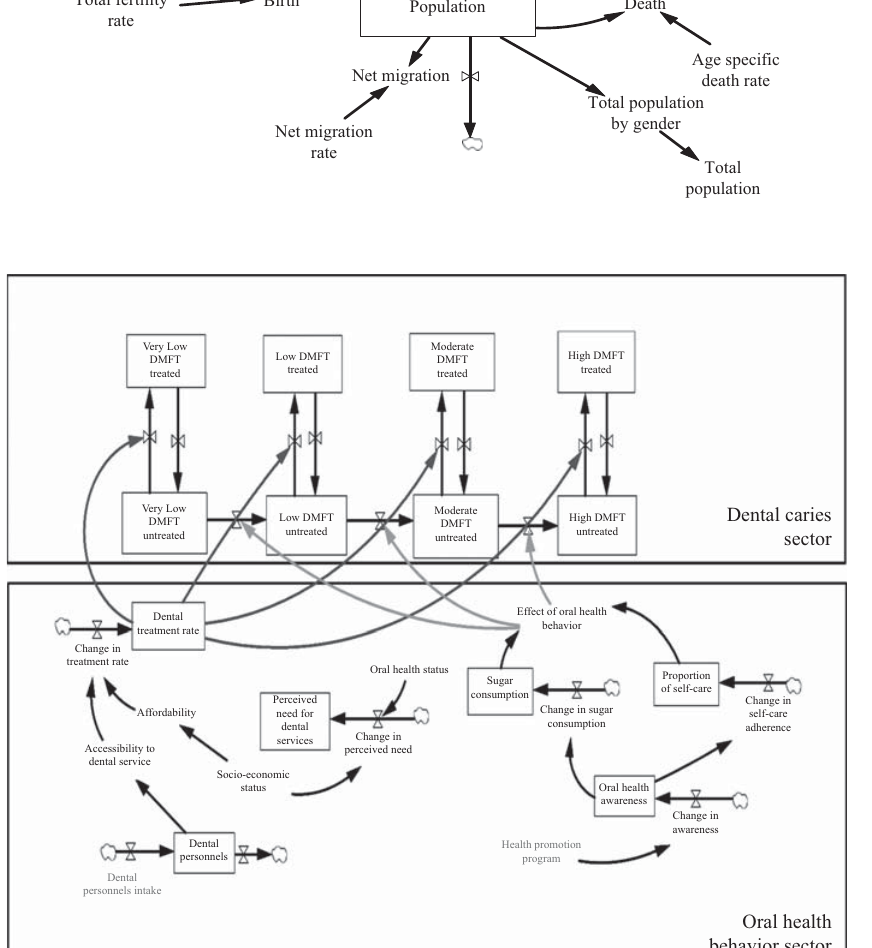
Figure 2. Combined